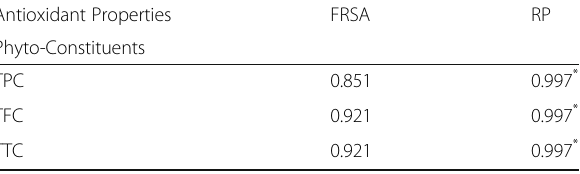
Table 2 Correlation coefficient between phytoconstituents and antioxidant properties of